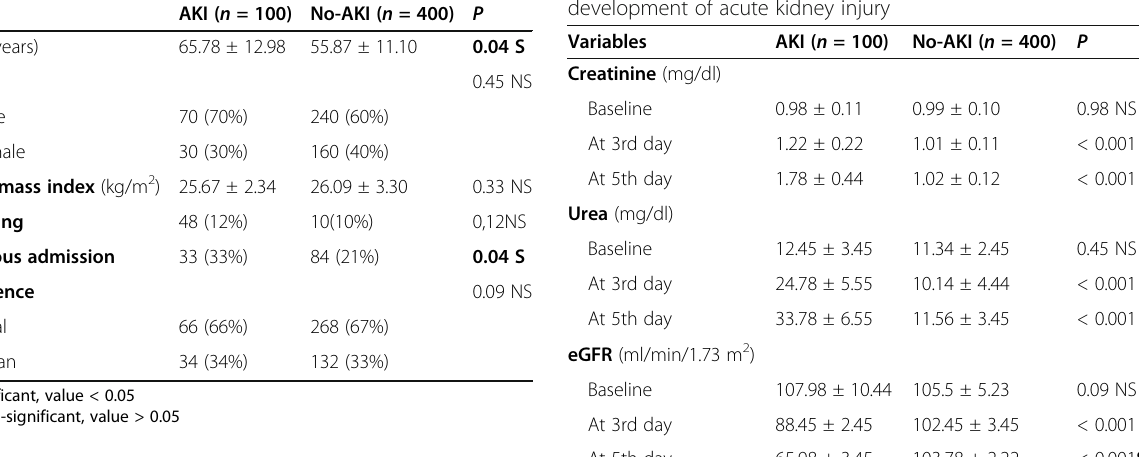
Table 1 Patient characteristics of studied patients